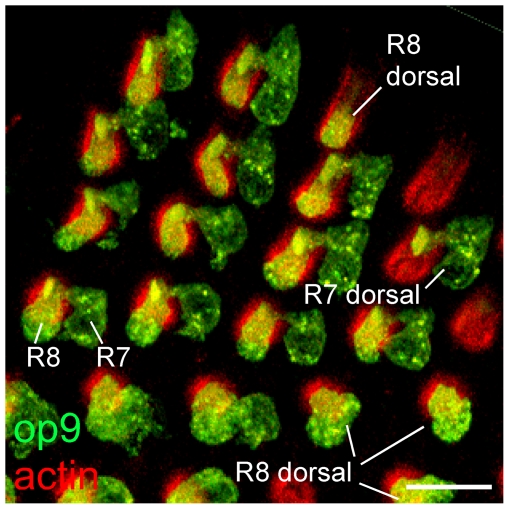
Mixed Aaop9 expression pattern at the dorsal-central transition area of the Ae. aegypti retina.Whole mount image of ommatidia located in the transition area between the dorsal and central region. Ommatidia on the left side are located in the dorsal region and express Aaop9 (green) in both R7 and R8 cell body and rhabdomere. One ommatidium showing Aaop9 rhodopsin expression (green) in the R7 cell but not the R8 cell is marked as “R7 dorsal”, and several ommatidia showing Aaop9 rhodopsin expression in R8 cell but not the R7 cell are marked as “R8 dorsal”. Actin is stained by phalloidin (red) to identify the rhabdom of all ommatidia. The orientation of ommatidia is similar to the inset drawing shown in Fig. 2D. The scale bar is ∼20 µm.